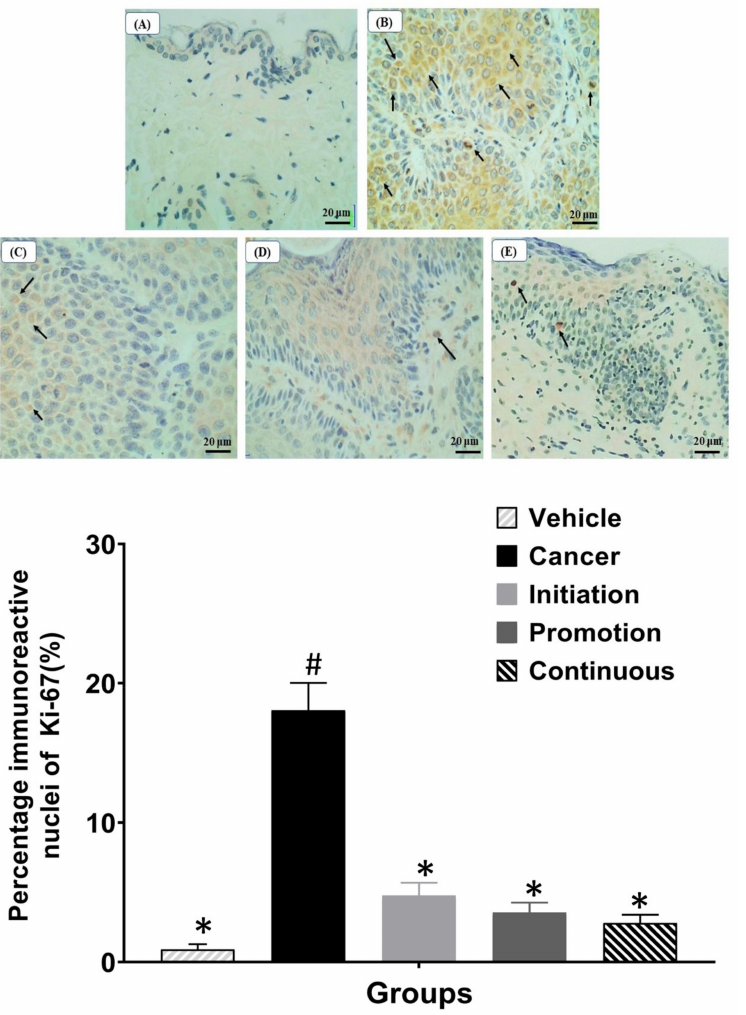
Figure 6. The images of immunohistochemistry of Ki-67 staining under the light microscope of 40 × magnification. ( A ): Vehicle, ( B ): Cancer, ( C ): Initiation, ( D ): Promotion, and ( E ): Continuous. The graph shows the percentage of immunoreactive nuclei of Ki-67 for each group. Arrows show the immunoreactive nuclei of Ki-67 with brown staining. * there is a statistically significant difference to the Cancer control group ( p < 0.05) at week 24. # there is a statistically significant difference to the Vehicle group ( p < 0.05) at week